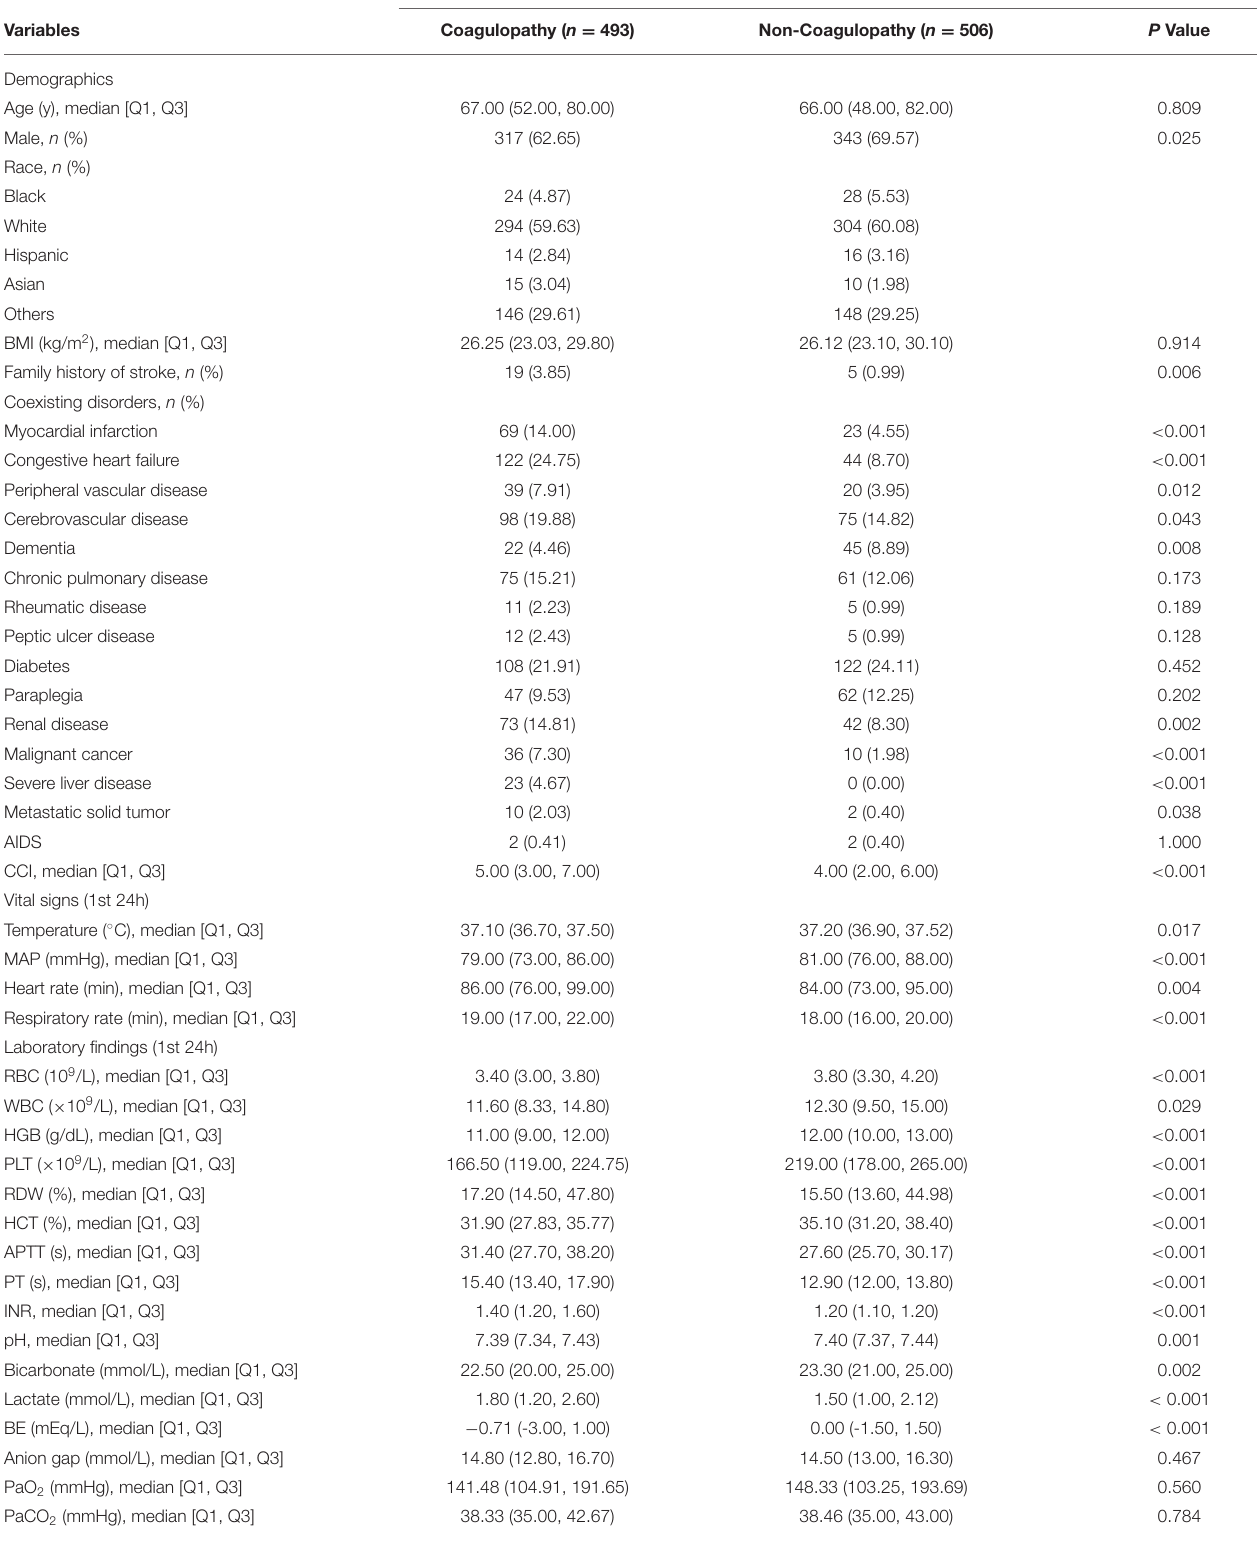
TABLE 1 | Baseline characteristics of the MIMIC-IV